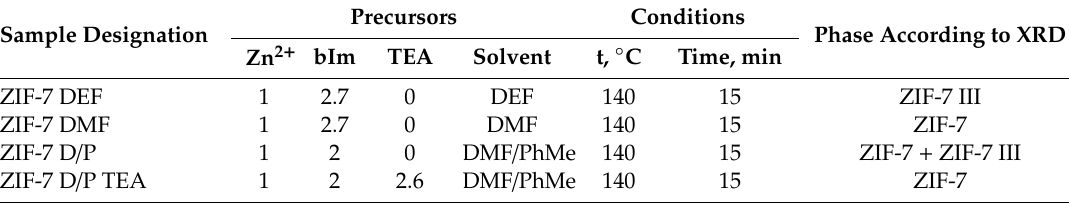
Table 1. Molar ratio of precursors and conditions applied for optimization of Zn-ZIF-7 MW synthesis. Sample